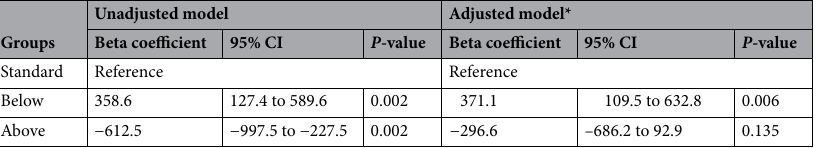
Table 2. Association between dose groups and diuretic response. *Adjusted for age, whether were taking oral loop diuretics before admission, white blood cell count, and levels of serum albumin, creatinine, potassium, and brain natriuretic peptide. CI confidence